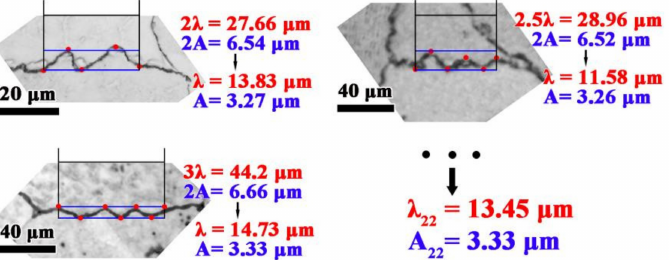
Figure 3. Calculation of the wavelength and amplitude of grain boundary serration.